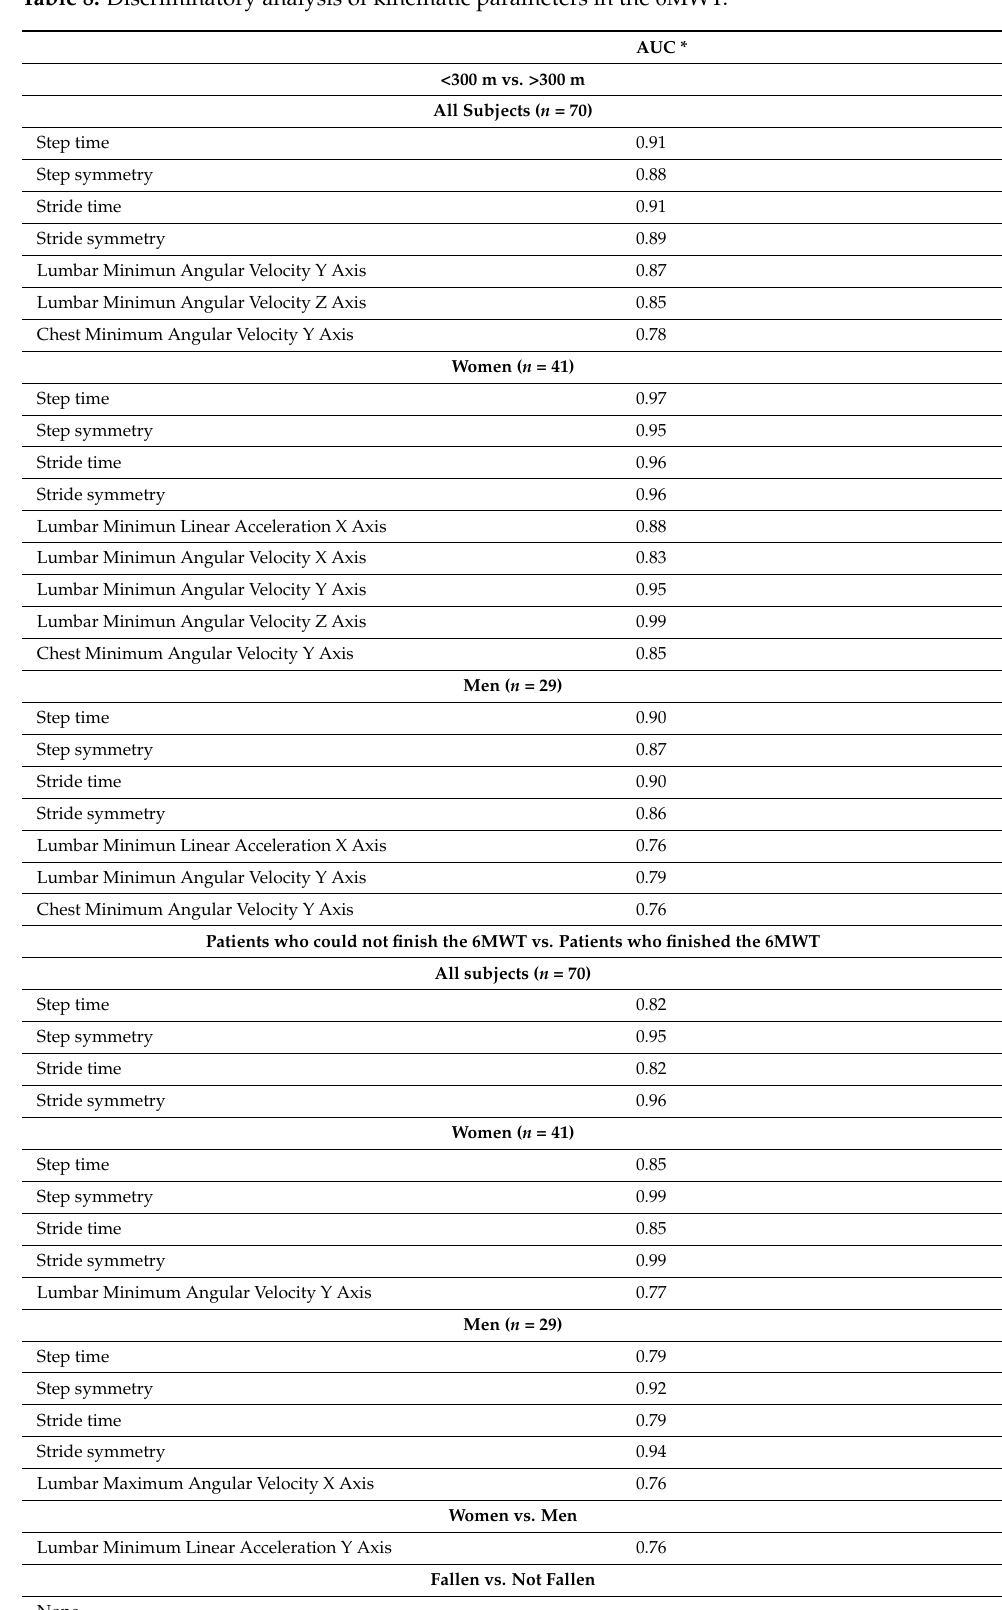
Table 8. Discriminatory analysis of kinematic parameters in the